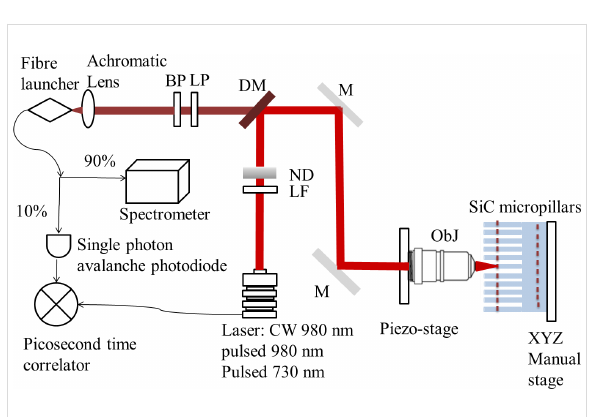
10% efficiency during measurement, and dead time set at 2 μ s) to measure the N C V Si emission (Figure 4).